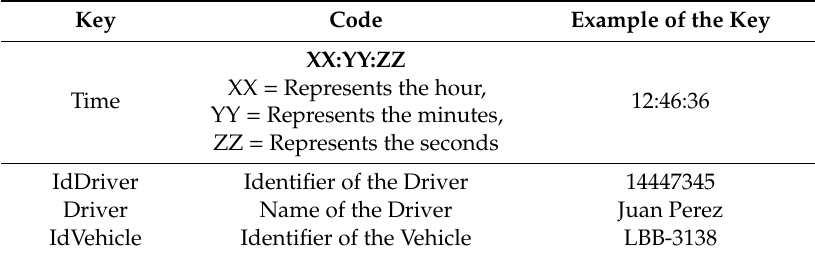
Table 10. Key variables in the